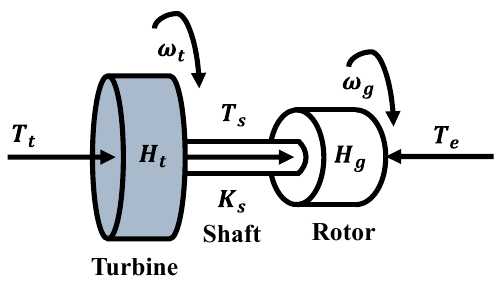
Figure 5. Drive train model.